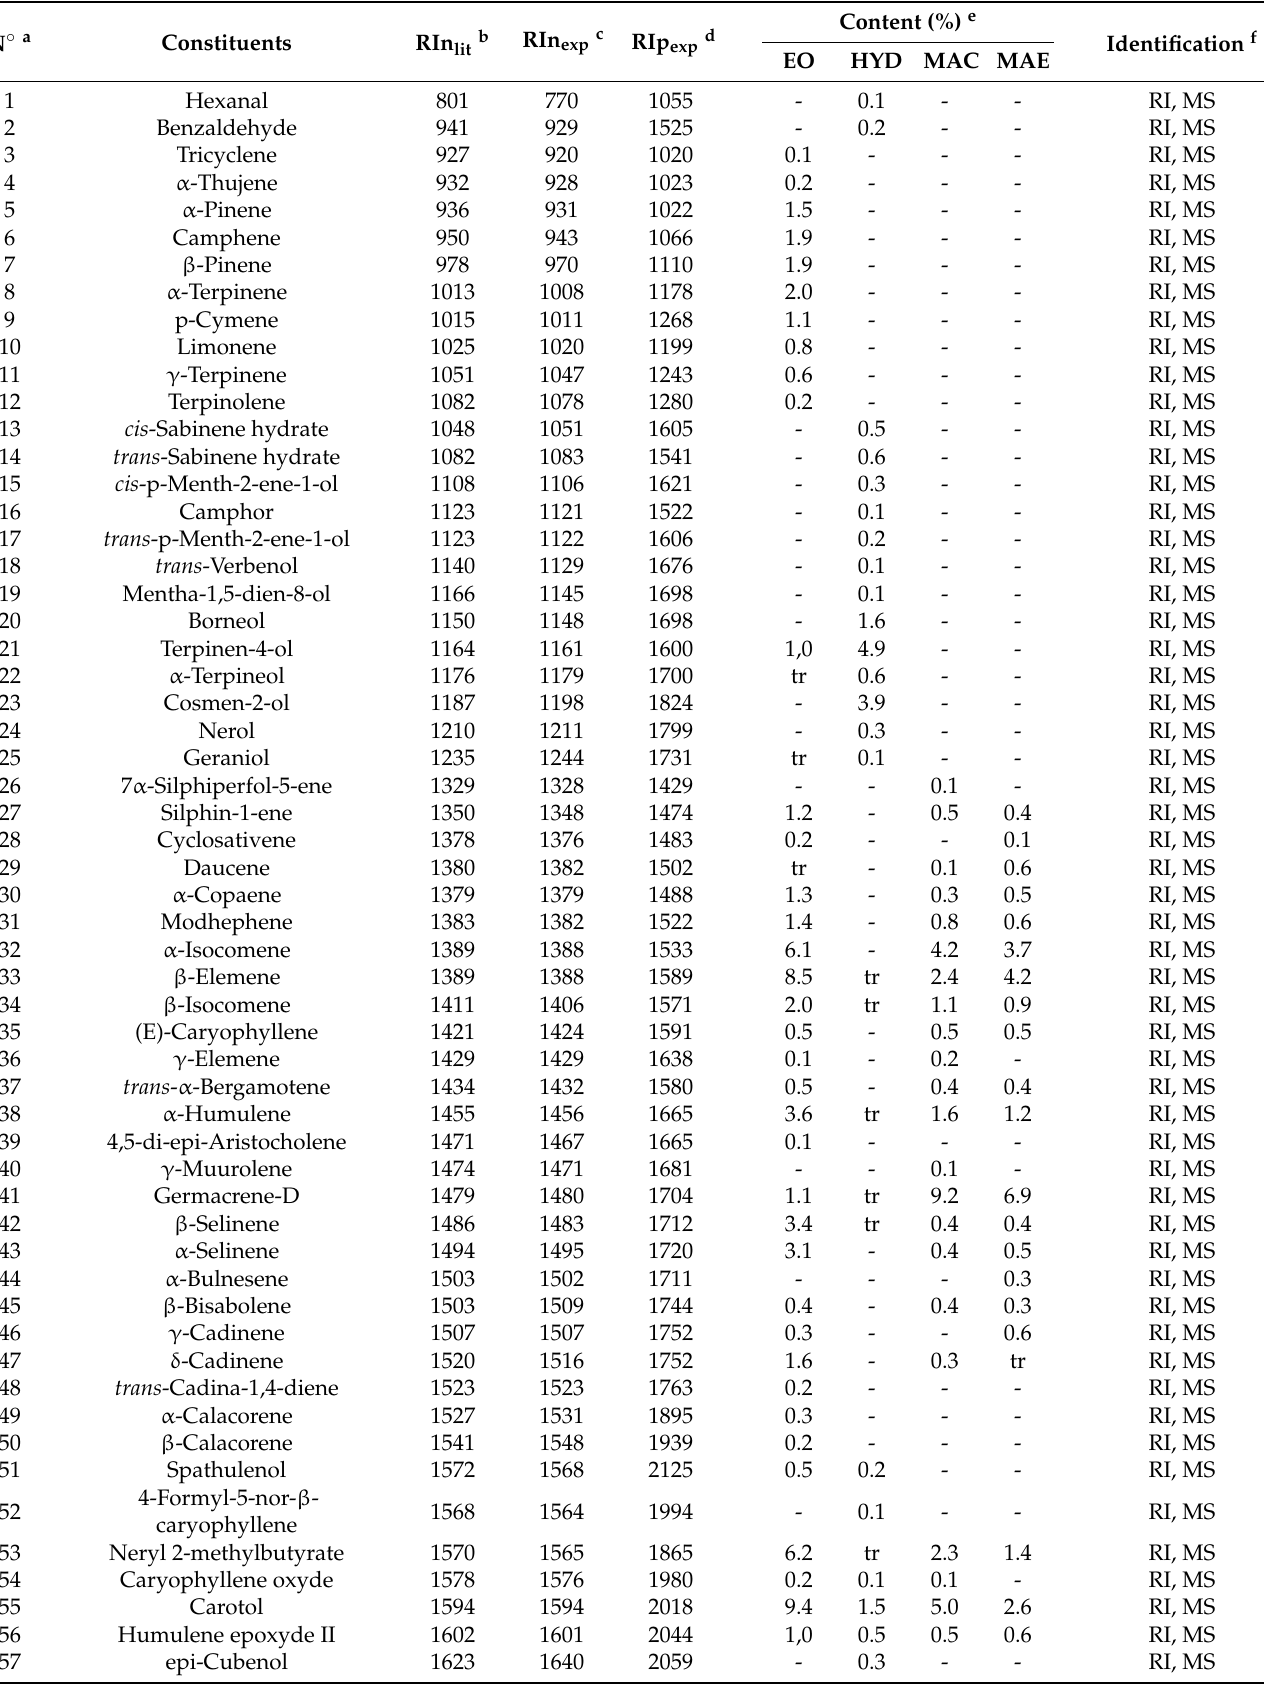
Table 1. Chemical compositions of X. spinosum